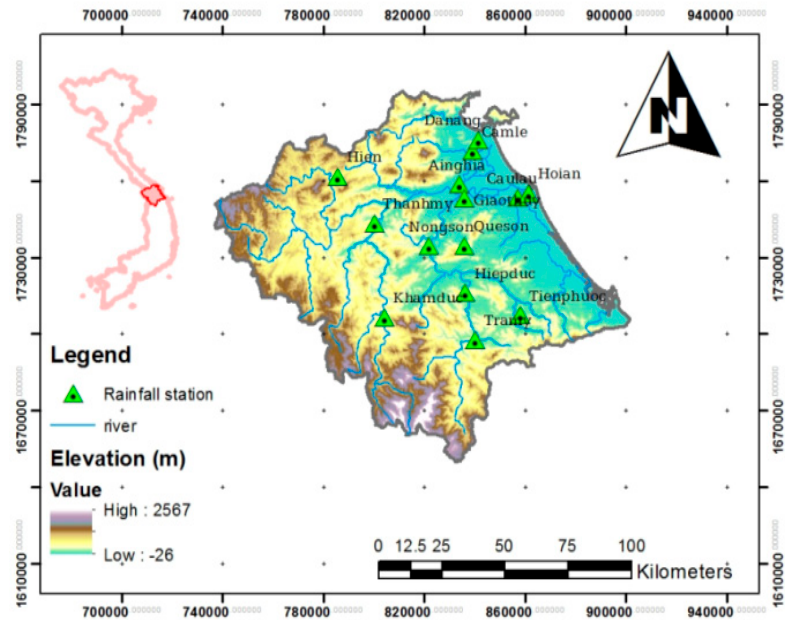
Figure 1. Network of hydro-meteorological stations at Vu Gia-Thu Bon (VG-TB) basin.